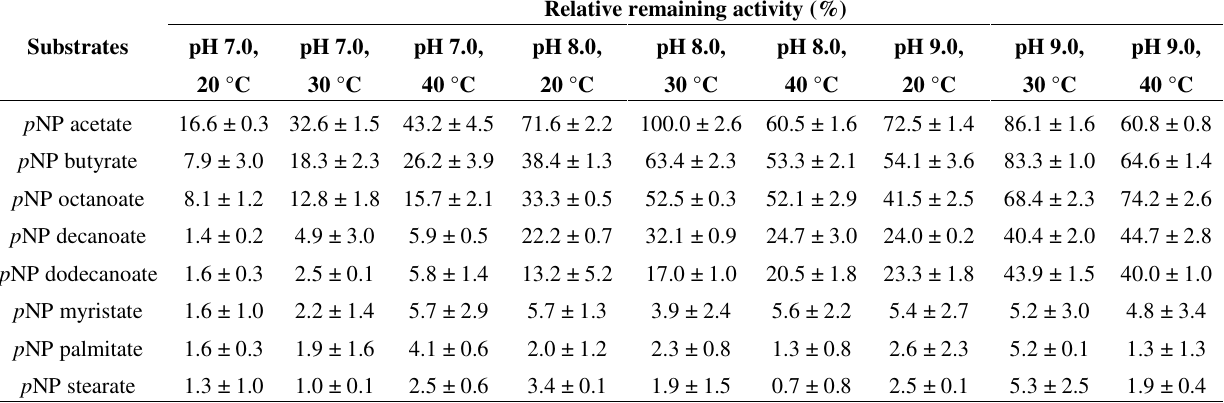
Table 4. Catalytic activities of r-LipA on different substrates under different pH values and temperatures. The reaction pH was in McIlvaine buffer (0.2 M Na pH 7.0) or 50 mM Tris-HCl buffer (pH 8.0 and 9.0), the temperature was at 20